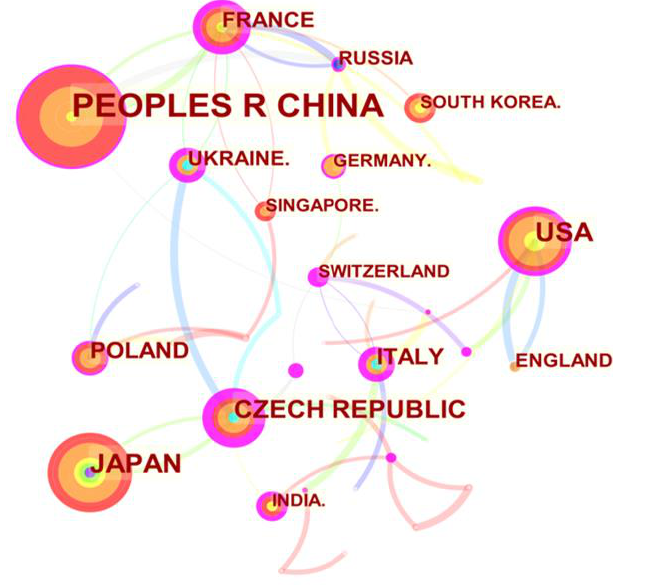
6 of 16 Figure 3. Annual and cumulative numbers of papers published on perovskite X-ray detectors from 1997 to 2022. 2.2. Macro Cooperation Network Analysis The year slice was set to 2 years, and the node type was countries; the created visual map is shown in Figure 4, and the top 10 countries exported are shown in Table 1. China, Japan, and the United States accounted for the top three in the literature quantity. Therein, there were 111 studies in China, 48 in Japan, and 41 in the United States. From the node color ring, China and the United States began to study perovskite X-ray detectors on a